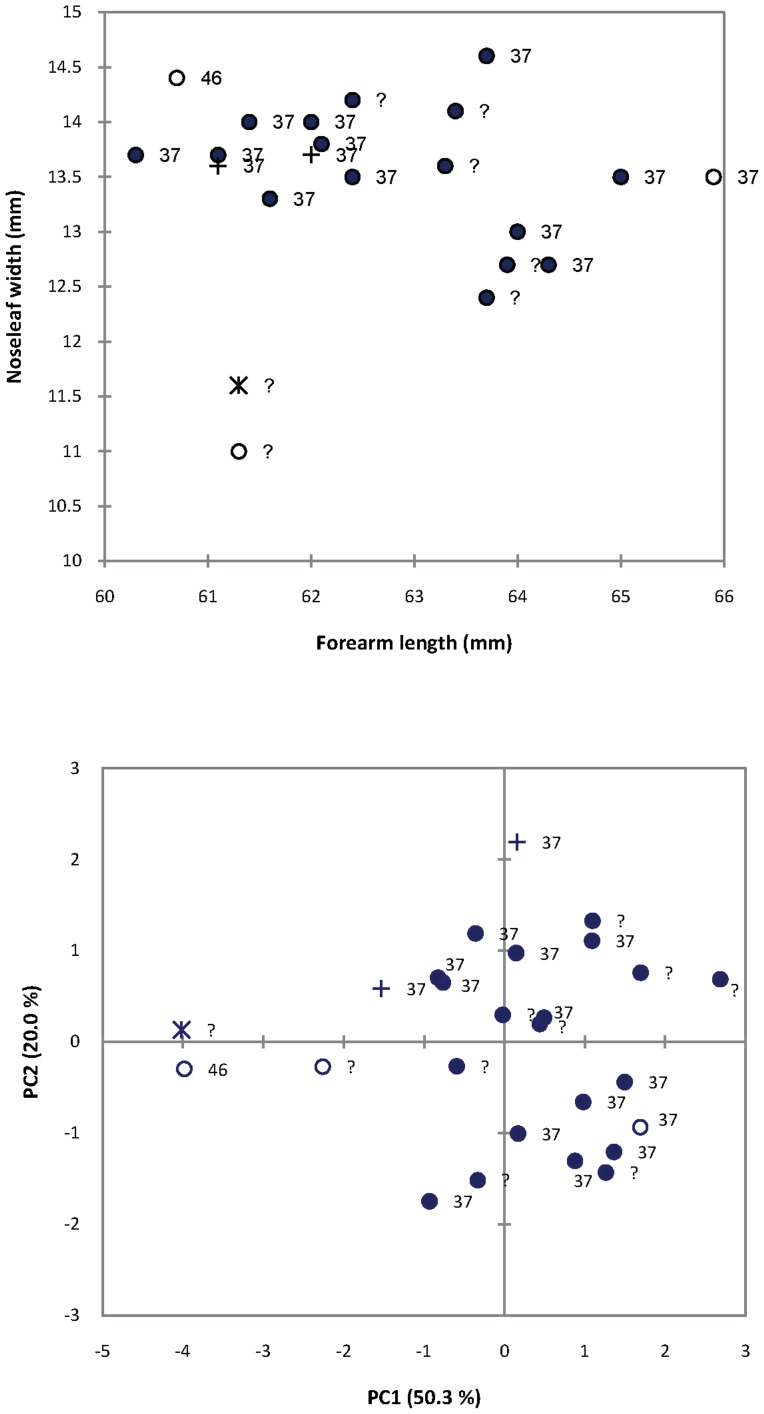
Morphometric variation in a series representing the R. hildebrandtii complex from Lutope-Ngolangola, Zimbabwe: a) biplot of forearm length versus noseleaf width and b) PCA of five craniometric variables (M3M3, CM3, IOC, NW, NH) in 26 individuals of known (37 or 46 kHz) and unknown (?) frequency.Females indicated by open circles, males by closed circles or crosses or asterisk. Voucher specimens for molecular sequencing study indicated by asterisk (Clade 1e:  = smithersii sp. nov.; see Taxonomic Conclusions) and crosses (Clade 2:  = mossambicus sp. nov.; see Taxonomic Conclusions). Hereafter, all individuals with a frequency of 37 kHz were assumed to belong to Clade 2 (mossambicus sp. nov.) and the 46 kHz individual was assumed to belong to Clade 1e (smithersi sp. nov.).